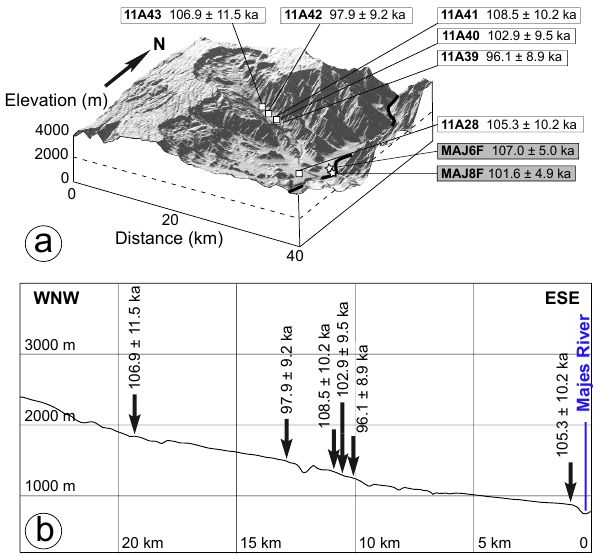
Figure 5. Samples location. (a) Digital elevation model (GeoMapApp, SRTM data, 90m resolution) of the study area, showing samples location and TCN ages obtained for the debris- flow deposit and the Acoy megafan surface. OSL ages obtained by Steffen et al. (2010) for the Acoy megafan are noted in grey. (b) El- evation profile locating debris flow and the Acoy megafan ages.